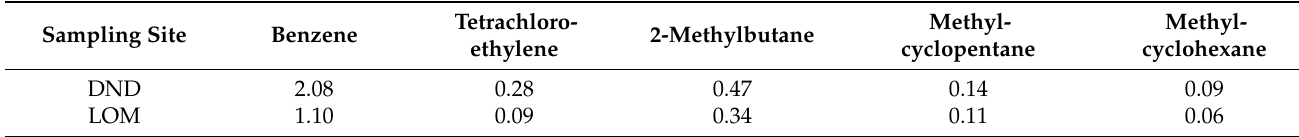
Table 4. Ratios of selected VOCs to toluene (ppbv/ppbv) in DND and LOM. Sampling Site Benzene